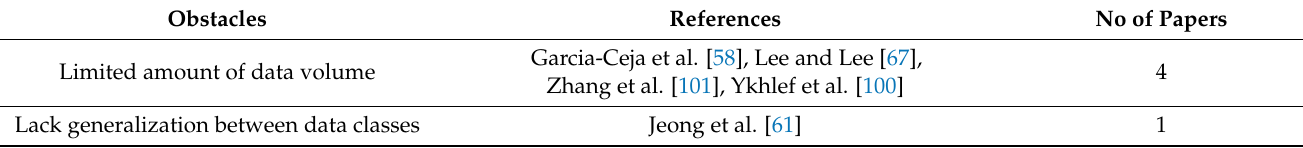
Table 6. Identified obstacles reported in the selected